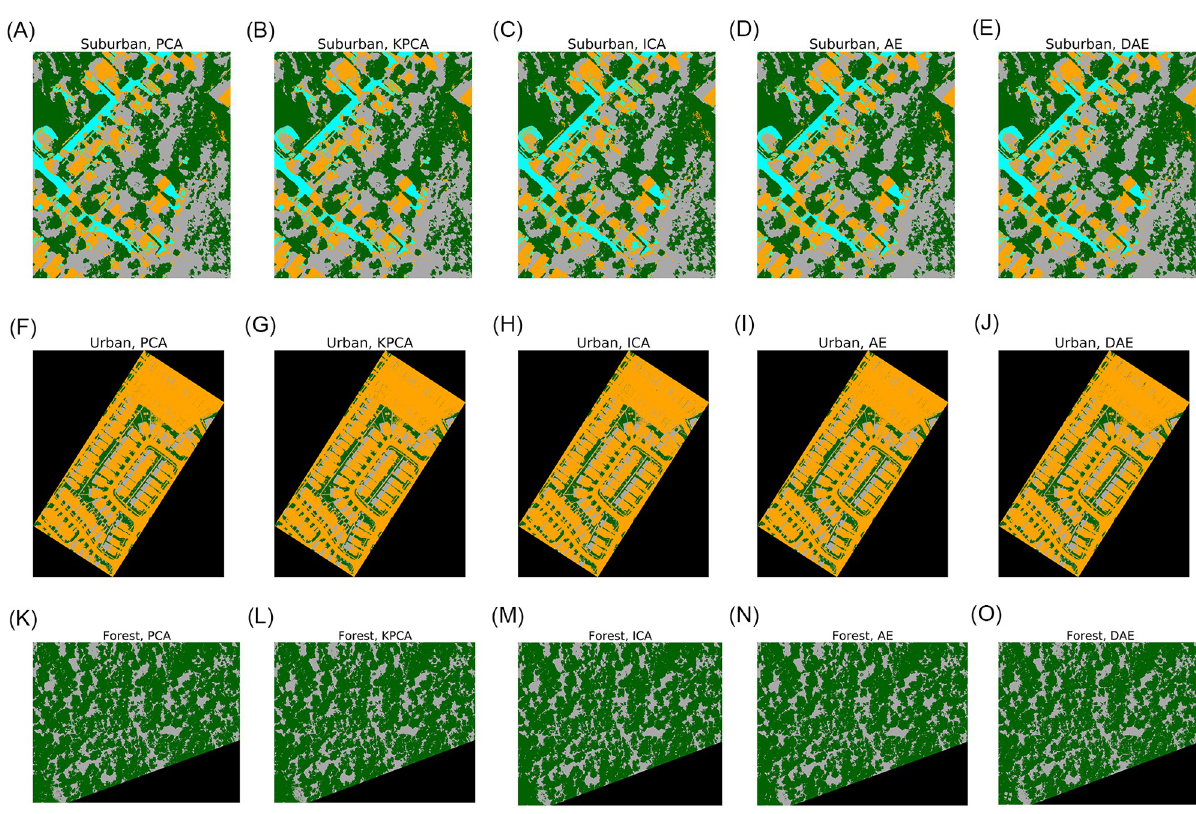
Fig 14. Classification images with spectra compressed to 95% of original